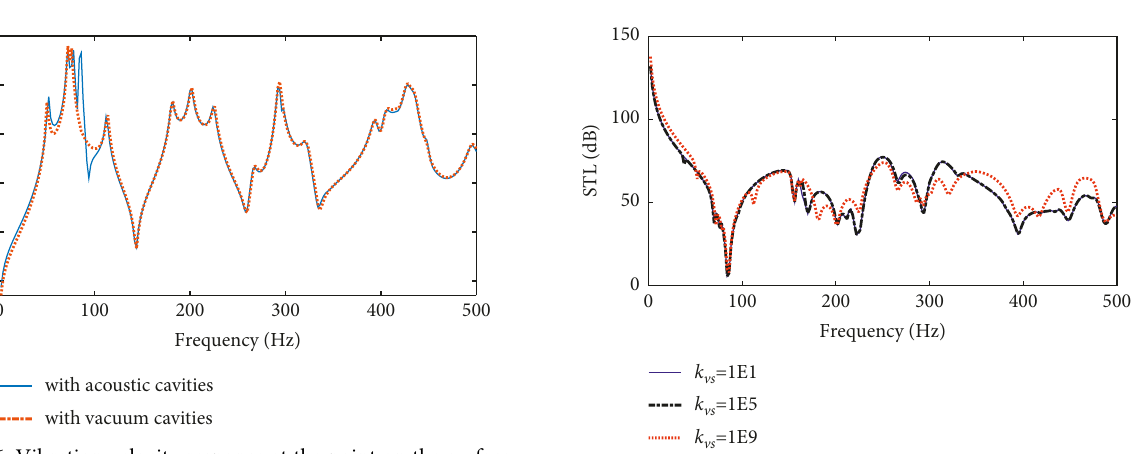
Figure 19: Sound transmission loss of the stiffened double panel- cavity coupled system with different stiffness amplitudes of boundary springs k vs .